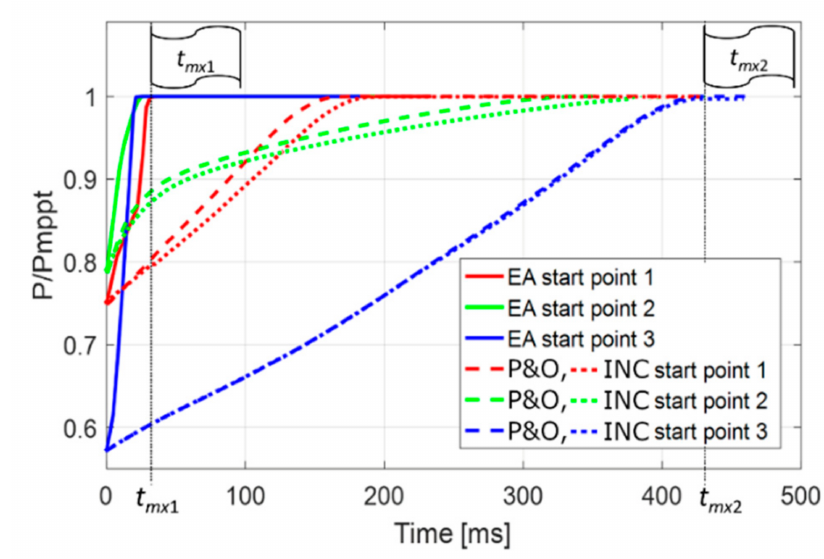
Figure 5. Convergence speed of the compared methods.